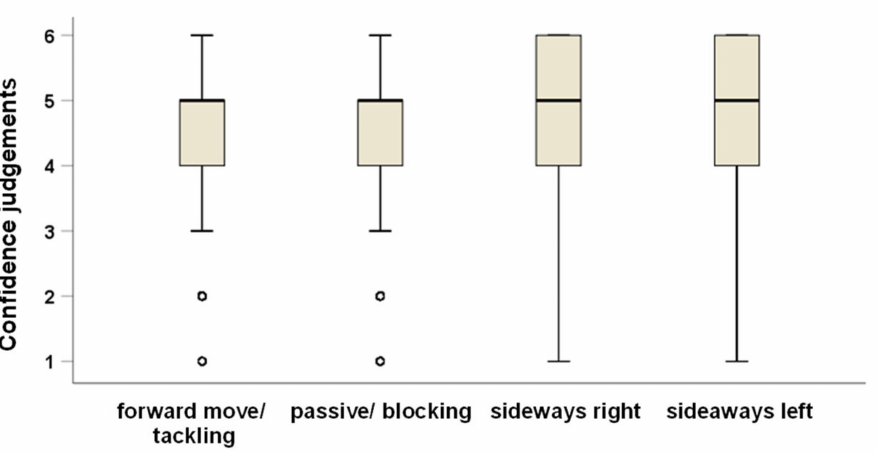
Figure 4. Box plots of mean confidence judgements (1 = absolutely ambiguous, 2 = ambiguous, 3 = indecisive, 4 = tendentious, 5 = unambiguous, 6 = absolutely unambiguous; Likert-type scale) for choice of motor response for all attack actions (both hands;